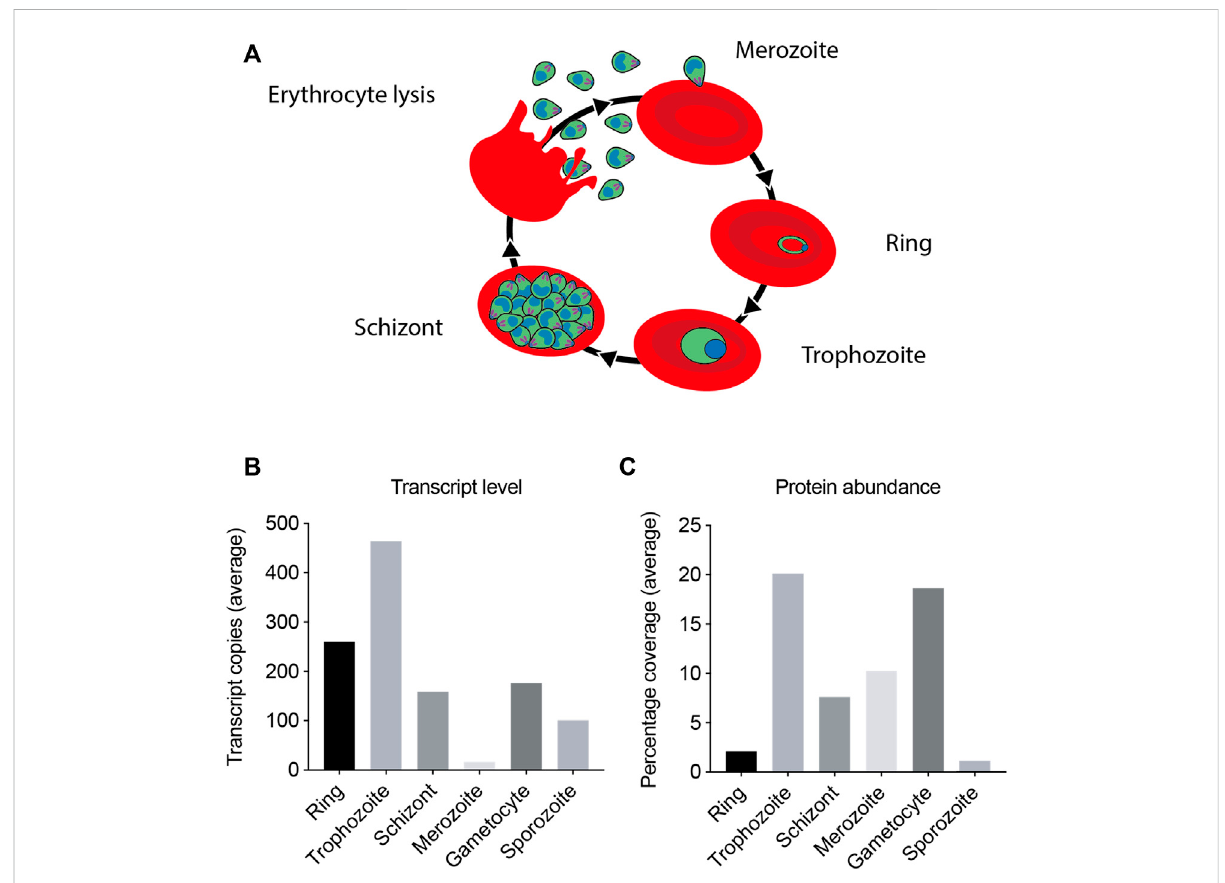
FIGURE 2 PfCCT complexmRNA transcript and proteinexpression levels. The PfCCT complexmRNA and protein expressionlevels have been monitored in a number of studies (Florens et al., 2002) (Nirmalan et al., 2004) (Bozdech et al., 2003), with maximal transcription and expression observed at the trophozoite stage. (A) Diagram of the asexual life cycle of P. falciparum in the human erythrocyte. (B) The transcript levels shown are the average number of RNA copies of all the eight subunits in the CCT complex, generated by microarray. (C) The protein expression levels shown are average percentage coverage of all the CCT subunits obtained by mass spectrometry analysis which is indicative of the CCT subunit protein abundance in the